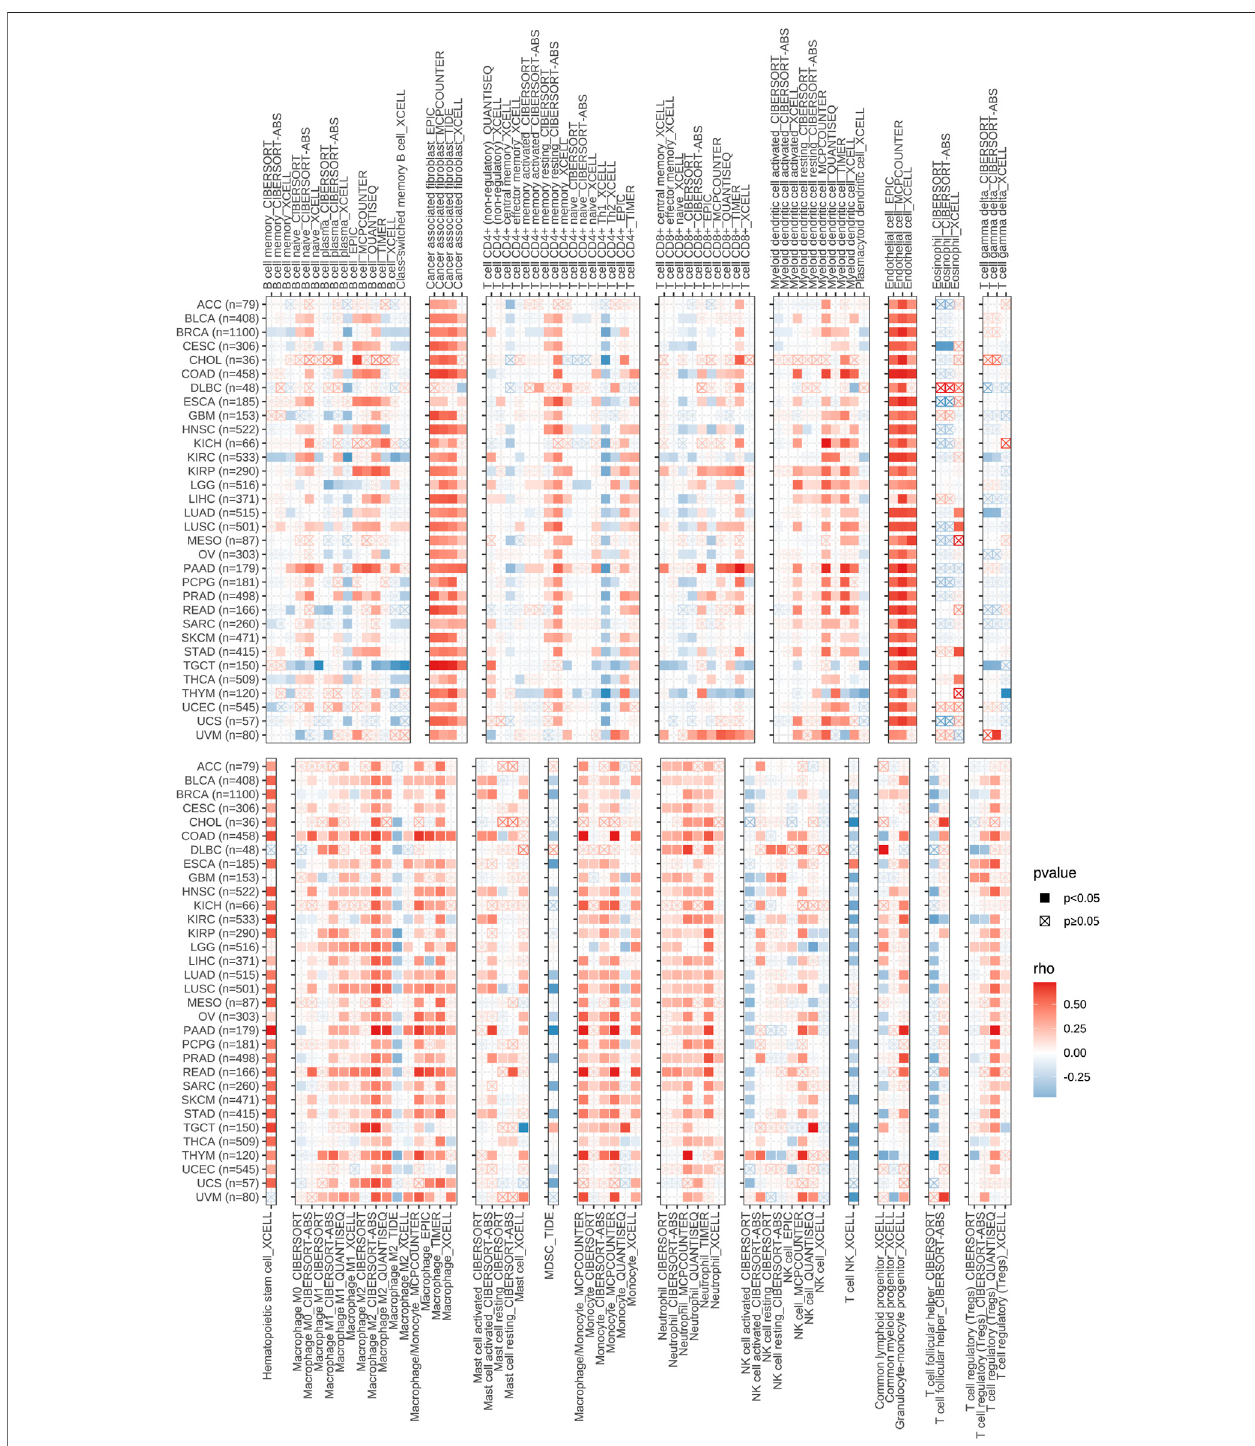
FIGURE 7 | The relevance of CD93 expression and immune in fi ltrates in pan-cancer.